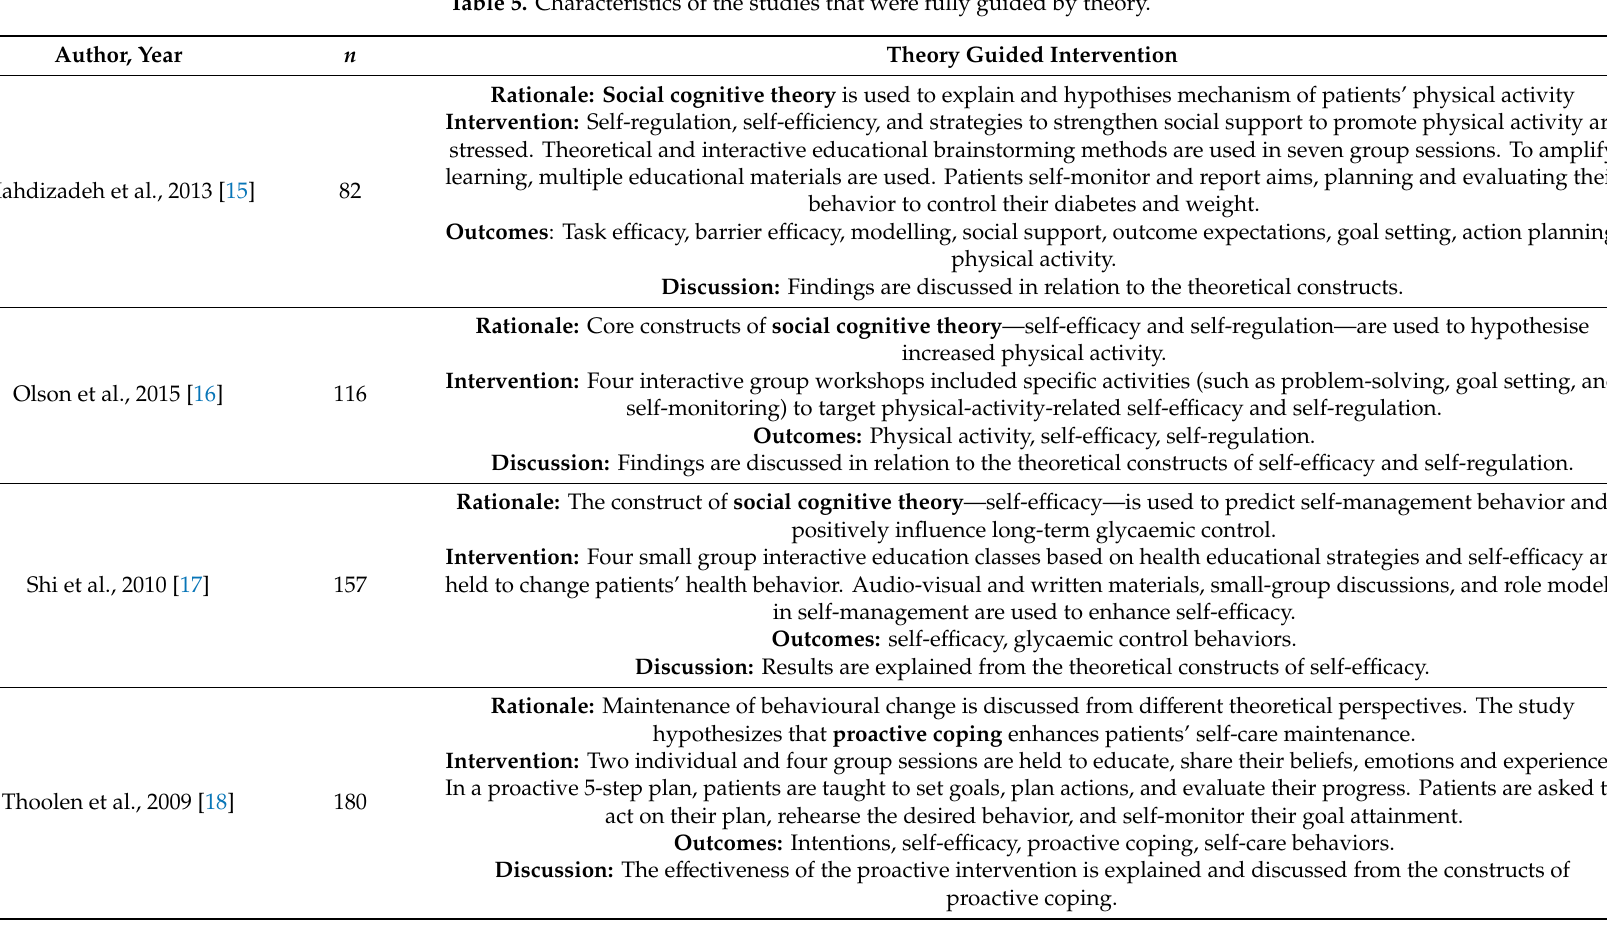
Table 5. Characteristics of the studies that were fully guided by theory.